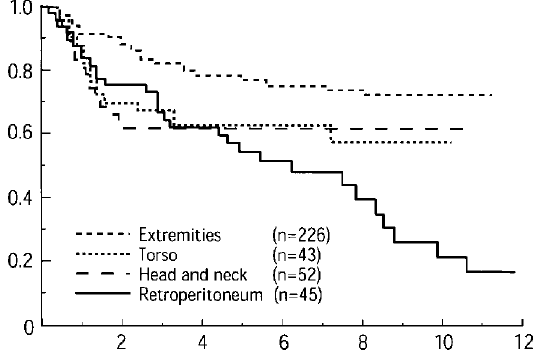
Fig. 2. Site-specific survival in patients with soft tissue sar- coma. Overall survival from the time of diagnosis is shown for patients treated with curative intent at The Princess Margaret Hospital for soft tissue sarcoma of the extremity, trunk, or head and neck (1980± 1988), and retroperitoneum (1975± 1988) (modified from References 1 and 19, with permission). approach in improving long-term disease control is, however, difficult to prove.